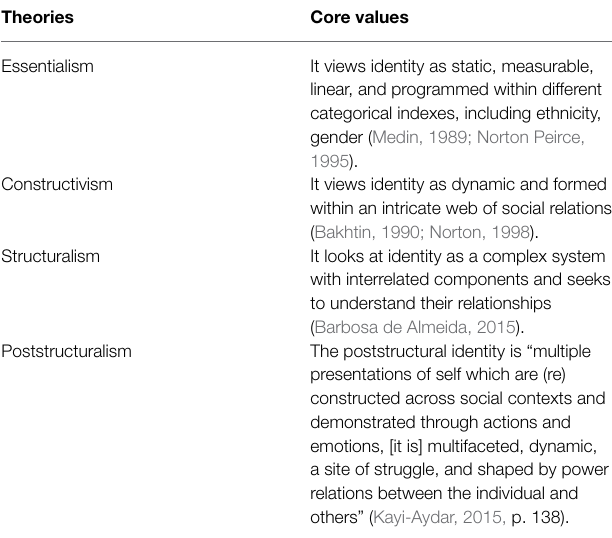
TABLE 1 | Understanding identity development through evolving